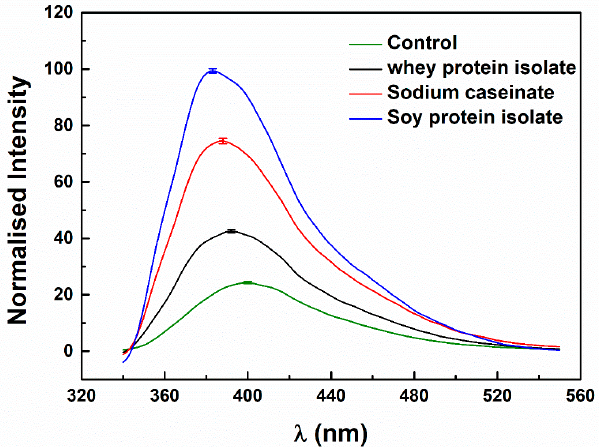
Figure 4. Fluorescence emission spectra of resveratrol in the absence (control) and presence of WPI, SC and SPI. Concentrations of resveratrol and proteins were 25 μ M and 0.1%,